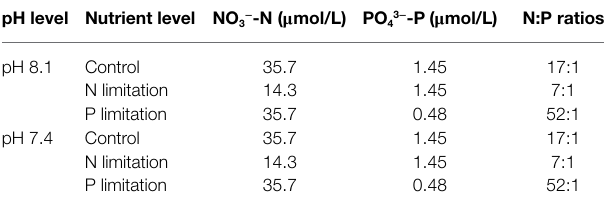
TABLE 1 | Seawater acidification and nutrient levels in different